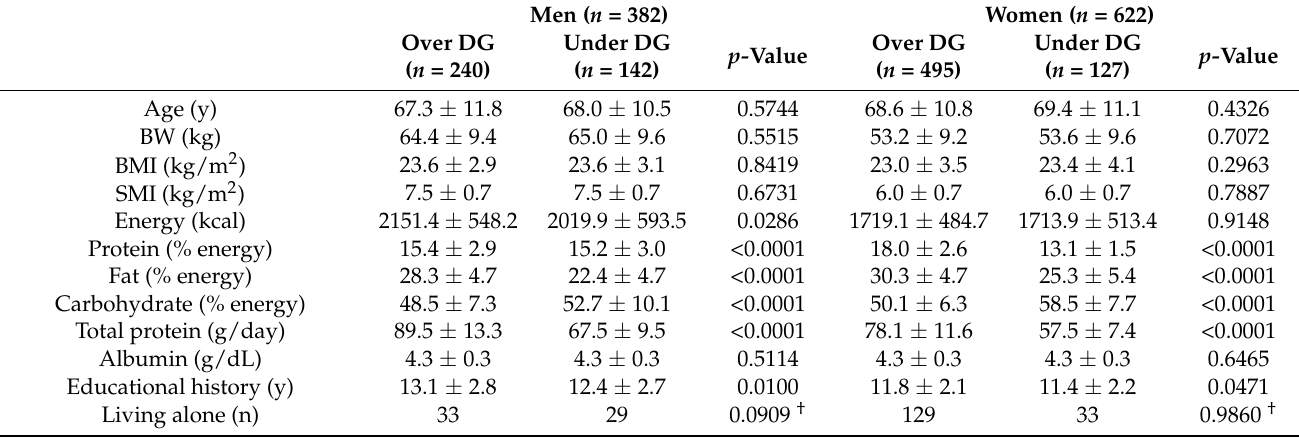
Table 4. Physical characteristics and social background according to over-DG and under-DG protein intake.